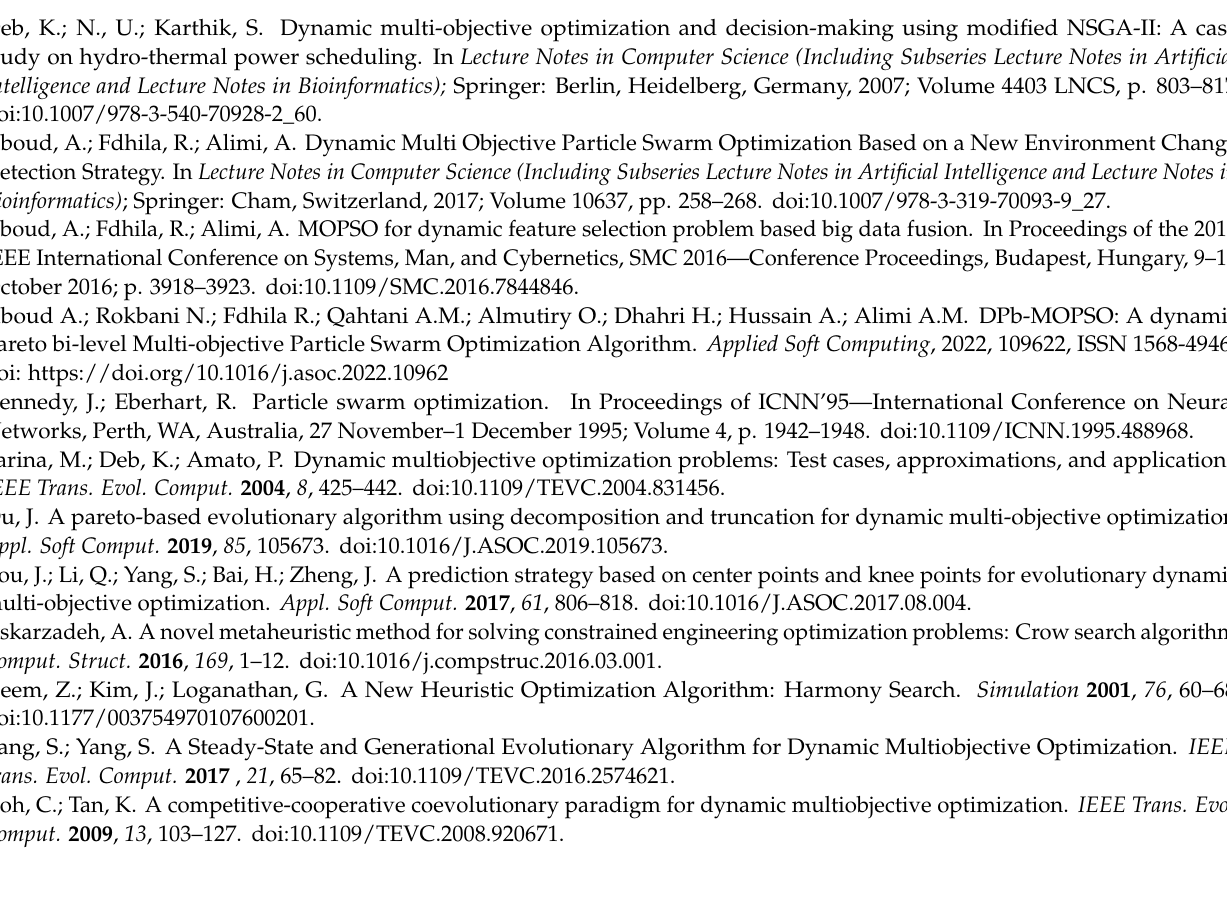
functions; Table S4: IGD results (Mean and Standard Deviation) of the 5 DMOEAs [11] compared to the standard CSA and the proposed DB-CSA algorithm for solving UDF and F(ZJZ) functions with ( τ t = n t = 10); Table S5: HVD results (Mean and Standard Deviation) of the 5 DMOEAs [11] compared to the standard CSA and the proposed DB-CSA algorithm for solving UDF and F(ZJZ) functions with ( τ t = n t = 10); Table S6: IGD results (Mean and Standard Deviation) of the 13 MOEAs [55] compared to the standard CSA and the proposed DB-CSA algorithm on the 2, 3 and 7 objective WFG problems; Table S7: IGD results (Mean and Standard Deviation) of the 13 MOEAs [55] compared to the standard CSA and the proposed DB-CSA algorithm on the 2, 3 and 7 objective MaF problems; Table S8: IGD results (Mean and Standard Deviation) of the 7 MOEAs [54] compared to DB-CSA on the WFG test suite; Table S9: IGD results (Mean and Standard Deviation) of the 7 MOEAs [54] compared to the standard CSA and the proposed DB-CSA algorithm on the DTLZ test